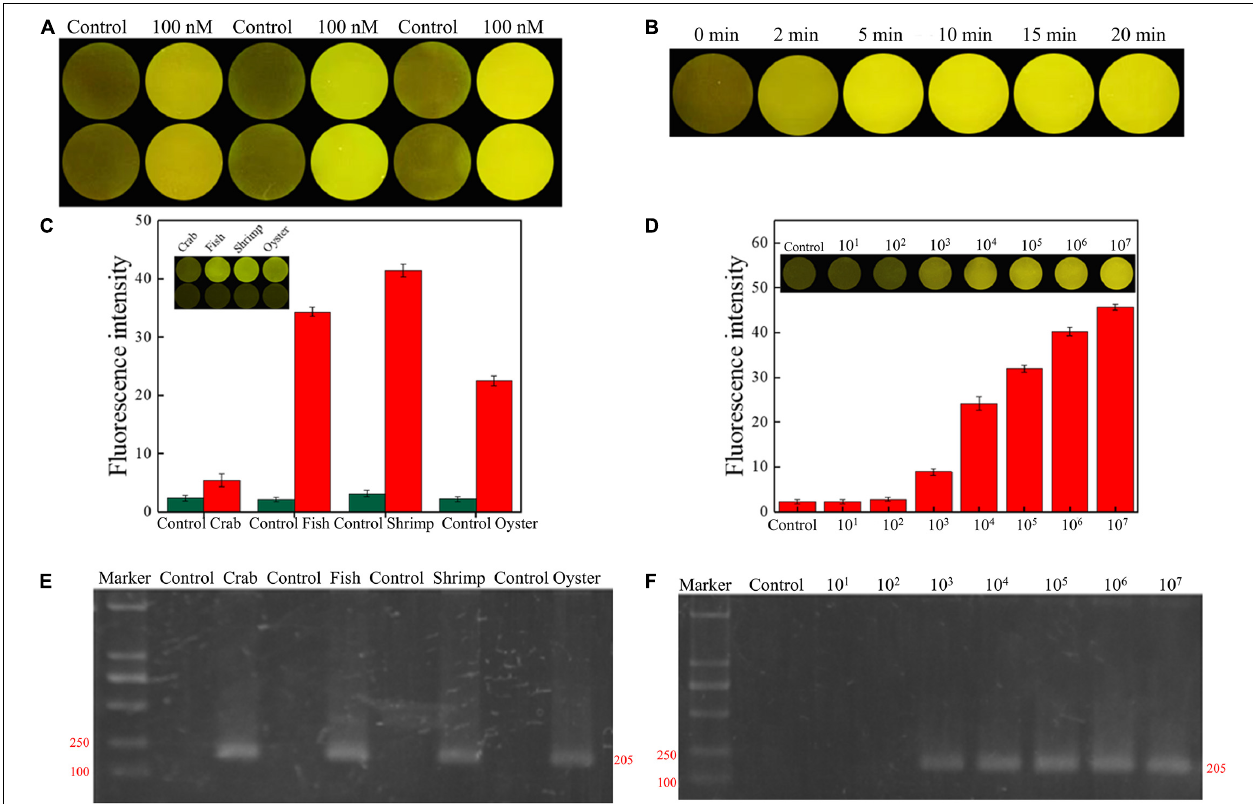
FIGURE 7 | (A) RFD-VV-M2 concentration optimization (100–300 mM) on the sensor. (B) Optimization of fluorescence reaction time (0–20 min). (C) Detection of V. vulnificus in crab, fish, shrimp, and oyster samples under the concentration of 10 7 CFU/ml. Red columns indicated different detection. Control: negative control. Inset: An active sensor exhibiting a positive fluorescent signal. (D) Detection of different concentrations of V. vulnificus in infected shrimp. Inset: The tissue fluid of infected shrimp rendered a fluorescent signal within 5 min. Control: negative control. (E) Corresponding agarose gel electrophoresis results of real-time PCR for V. vulnificus detection with primers L-vvh and R-vvh. M, D2000 Plus DNA marker; Control, negative control. (F) Corresponding agarose gel electrophoresis results of real-time PCR for shrimps spiked with V. vulnificus. M, D2000 Plus DNA marker; Control: negative